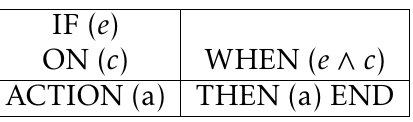
Table 1. Modeling a context rule by an Event-B